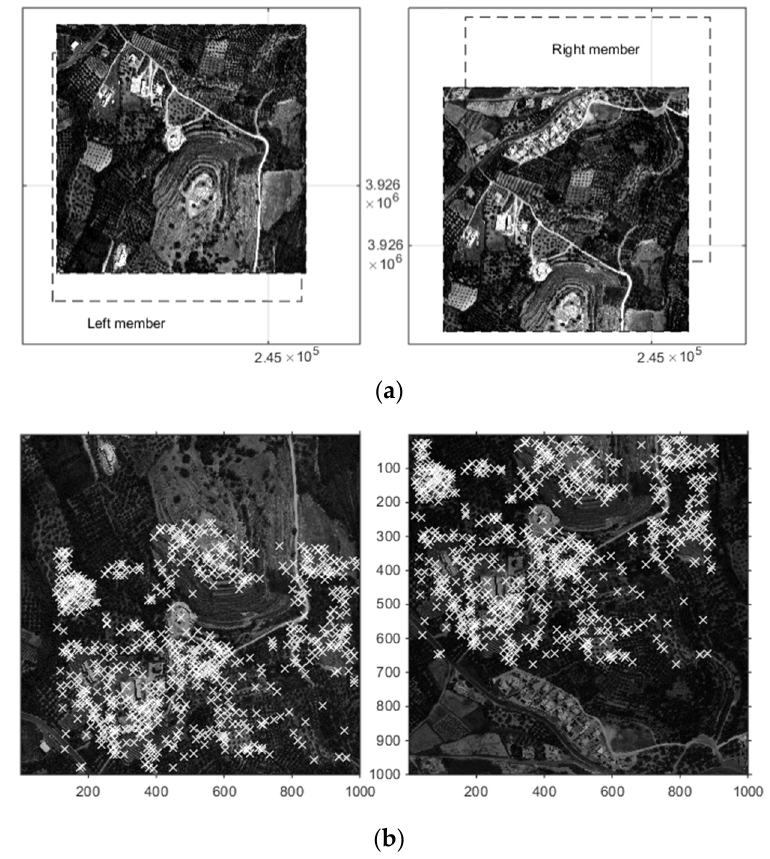
Figure 4. Members of a sample Geoeye-1 stereo pair from Almirida watershed. Images are shown at original positioning, and dashed lines show their respective location after rough georeferencing with their Rational Function Models (RFMs) ( top pair ). A fast image matching is used to determine homologous features ( bottom pair ). Axes units in pair ( a ) in m of the Greek National Grid coordinate system. Axes units in pair ( b ) in pixels.